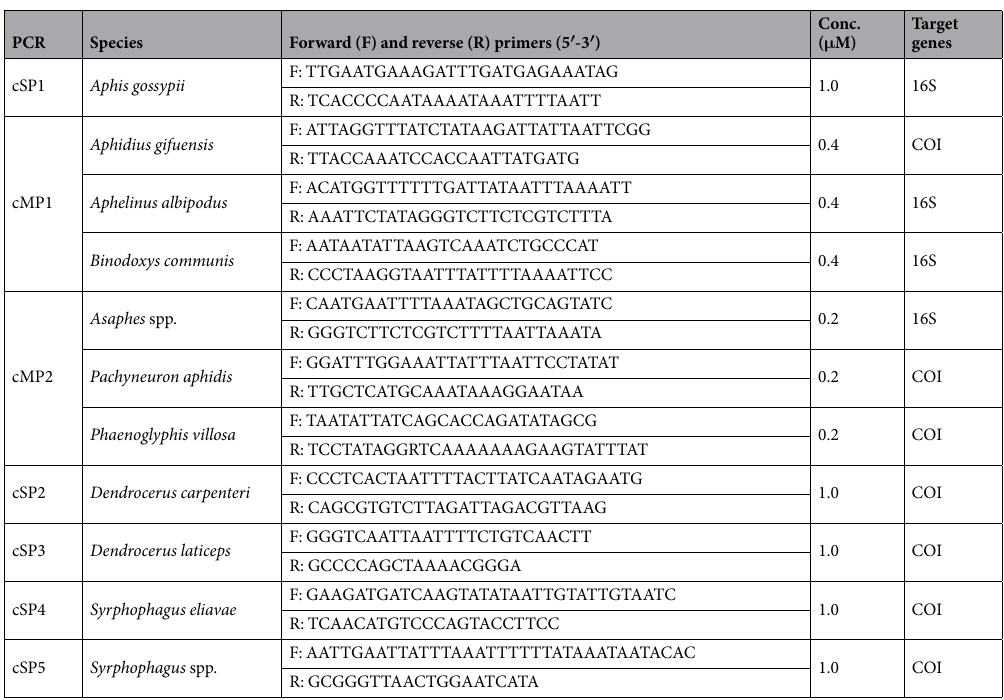
Table 2. Primers used in the cotton aphid-parasitoid multiplex PCR